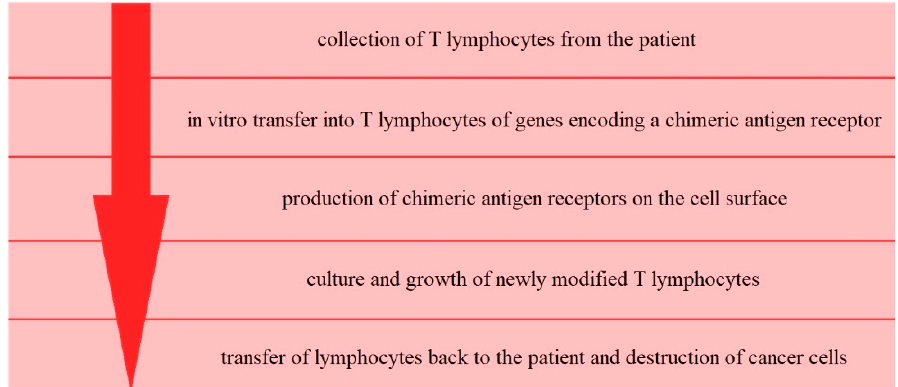
Figure 3 . Scheme of the process of CAR-T therapy . Figure 3. Scheme of the process of CAR-T